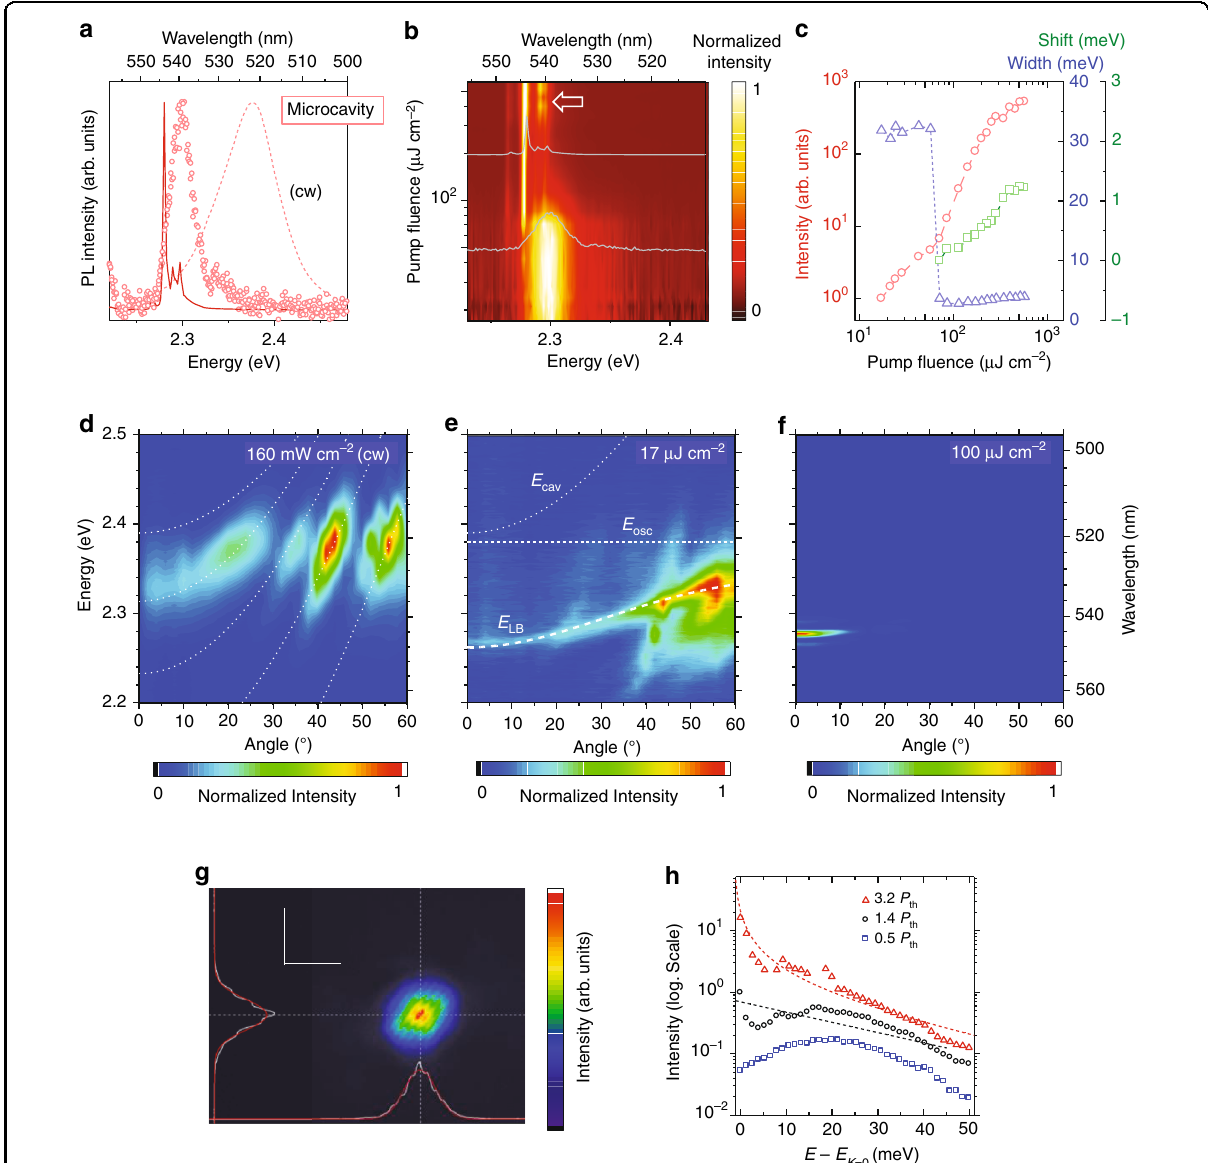
Fig. 4 PL characteristics of CsPbBr 3 microcavity. a Normalized PL spectra under I p of ~17 μ J cm − 2 (open circle) and ~200 μ J cm − 2 (solid curve). The data are obtained by integrating the emission of radiation angles within < ~20°. Dashed curve shows a result under cw excitation. b 2D pseudo- color plot of normalized PL spectra as a function of pump fl uence. As a help to the reader, PL spectra obtained at the fl uence of 50 μ J cm − 2 and 200 μ J cm − 2 are also shown (gray curves). c Fluen c e-dependent emission intensity (red circles), linewidth (blue triangles), and peak energy shift (green squares). The peak energy shift is de fi ned to be a deviation from 2.280 eV. d – f Color maps of angle-dependent PL spectra obtained under d cw-160 mW cm − 2 excitation, e pulsed-17 μ J cm − 2 pumping (below threshold), and f pulsed-100 μ J cm − 2 pumping (above threshold). The excitation densities expected for these conditions are d ~2.9 × 10 15 cm − 3 , e ~2.7 × 10 18 cm − 3 , and f ~1.6 × 10 19 cm − 3 , respectively. Dotted curves and a dashed line exhibit uncoupled cavity-photon modes and exciton mode, respectively. A thick dashed curve shows a lower branch of coupled modes. g Microscopic emission image observed under the above-threshold pumping fl uence. Spatial resolution is ~200 nm. A stabilized Michelson interferometer equipped with a retrore fl ector is employed to observe interference fringes due to long-range phase coherence. The scale bars are 2.5 µm. h Occupancy of excited particle deduced from far- fi eld emission data shown in ( b ). Below- (blue square), around- (black circle), and above- (red triangle) threshold data are shown. The horizontal axis shows energy shift from the energy at k = 0. Black dashed line exhibits Maxwell – Boltzmann distribution function with k B T = 26 meV. Red dashed curve reveals Bose distribution function with k B T = 26